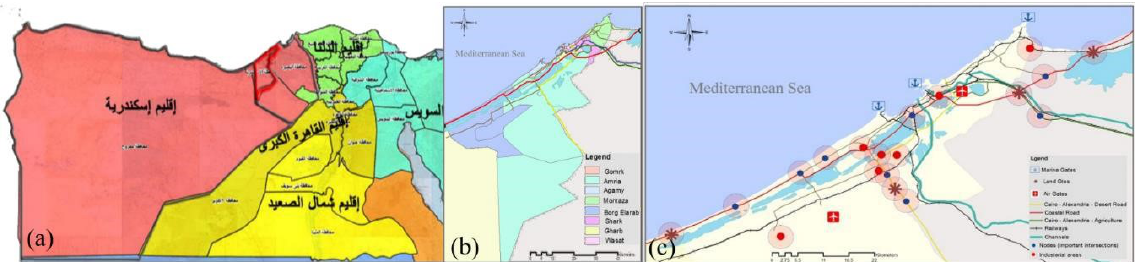
Figure 1. Alexandria region between Egyptian regions at fig 1a, Alexandria districts at fig 1b, and main nodes and intersections at 1c.